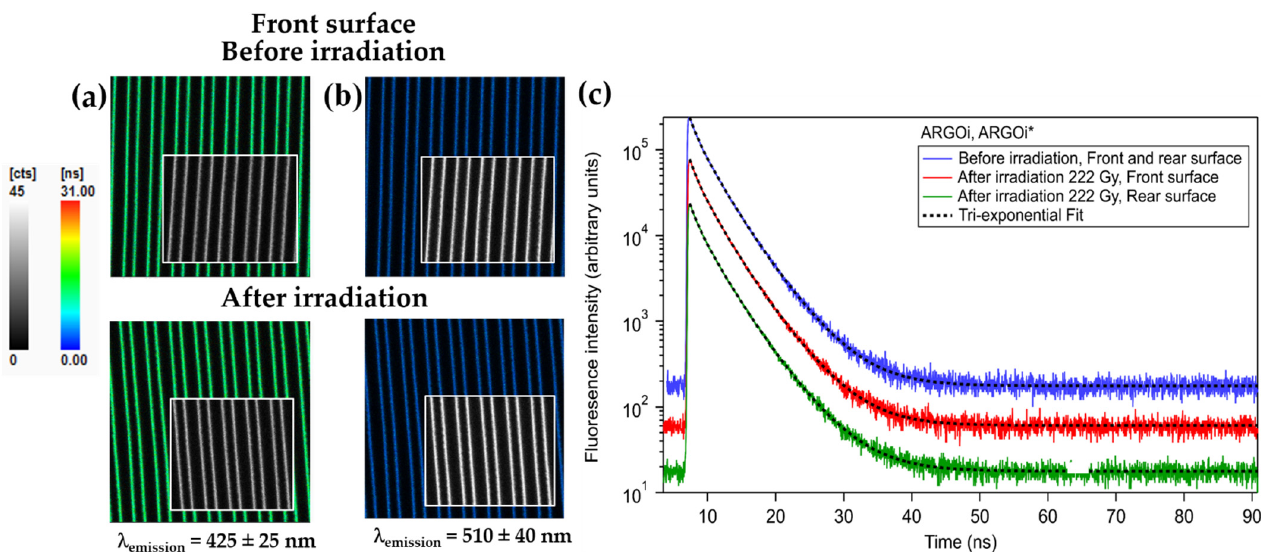
Figure 13. ( a ) Composite FLIM and fluorescence intensity microscopy images of the laser-induced structure (11 TW/cm 2 ) before and after irradiation for an emission at 425 nm from the front surface; the color-code represents the mean lifetime obtained by FAST-FLIM algorithm (color scale from 0 to 31 ns); inset: luminescence intensity only (grey-scale from 0 to 45 counts). ( b ) Same composite FLIM and luminescence intensity images for an emission at 510 nm. ( c ) Luminescence decays in arbitrary units for the emission at 425 nm of the same structure before and after irradiation for the two surfaces, and fitting curves thereof using three exponential decay functions.